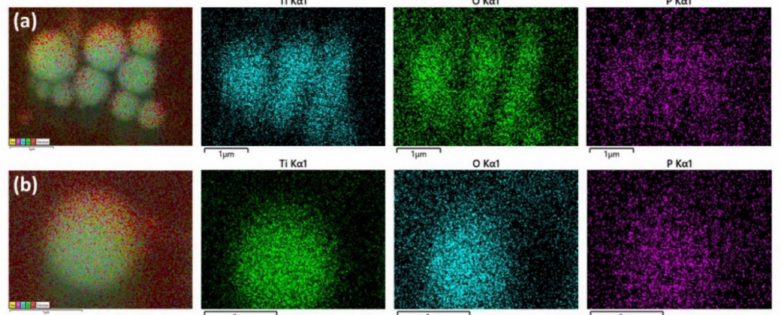
Figure 2. Elemental mapping of self-assembled nanoshells, showing the presence of titanium, oxygen, and phosphorous. Analysis of ( a ) an aggregate of self-assembled hollow spheres and ( b ) an individual hollow